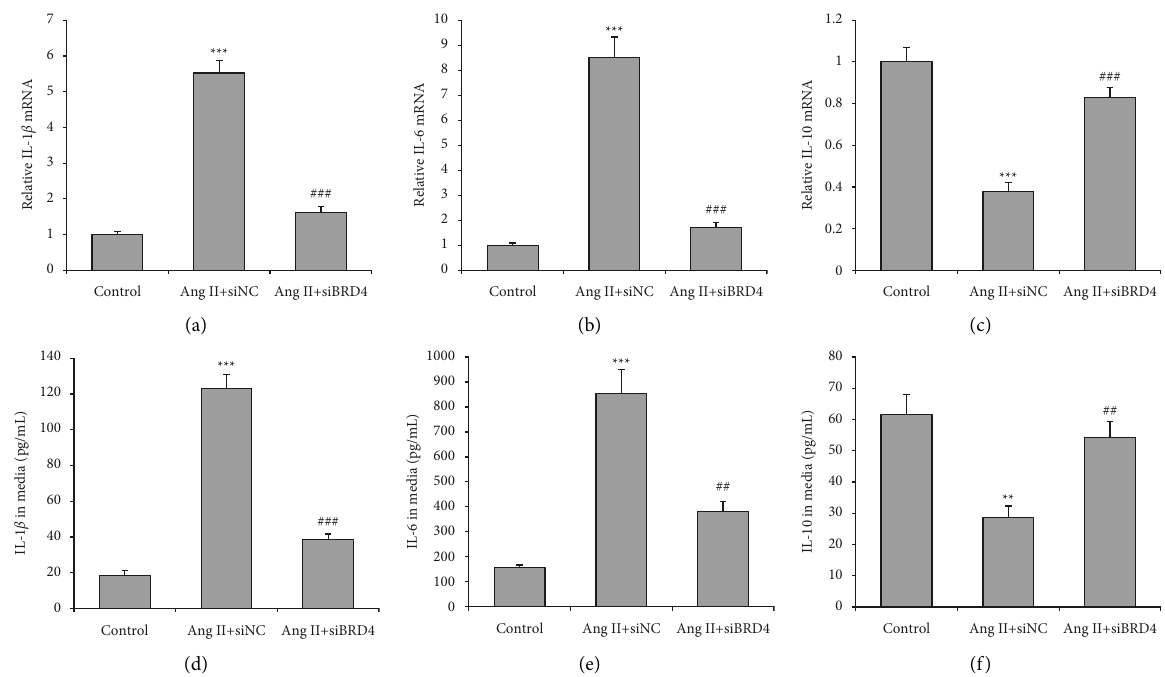
Figure 4: siBRD4 attenuates the Ang II-induced inflammatory response in H9c2 cells. A real-time PCR was performed to detect the mRNA levels of IL-1 β (a), IL-6 (b), and IL-10 (c) in H9c2 cells. ELISA was performed to detect the secreted IL-1 β (d), IL-6 (e), and IL-10 (f) in the cell supernatant of H9c2 cells. Each experiment was performed in triplicate and repeated at least three times. ∗∗ P < 0 . 01, ∗∗∗ P < 0 . 001 vs. control group; ## P < 0 . 01, ### P < 0 . 001 vs. Ang II+siNC